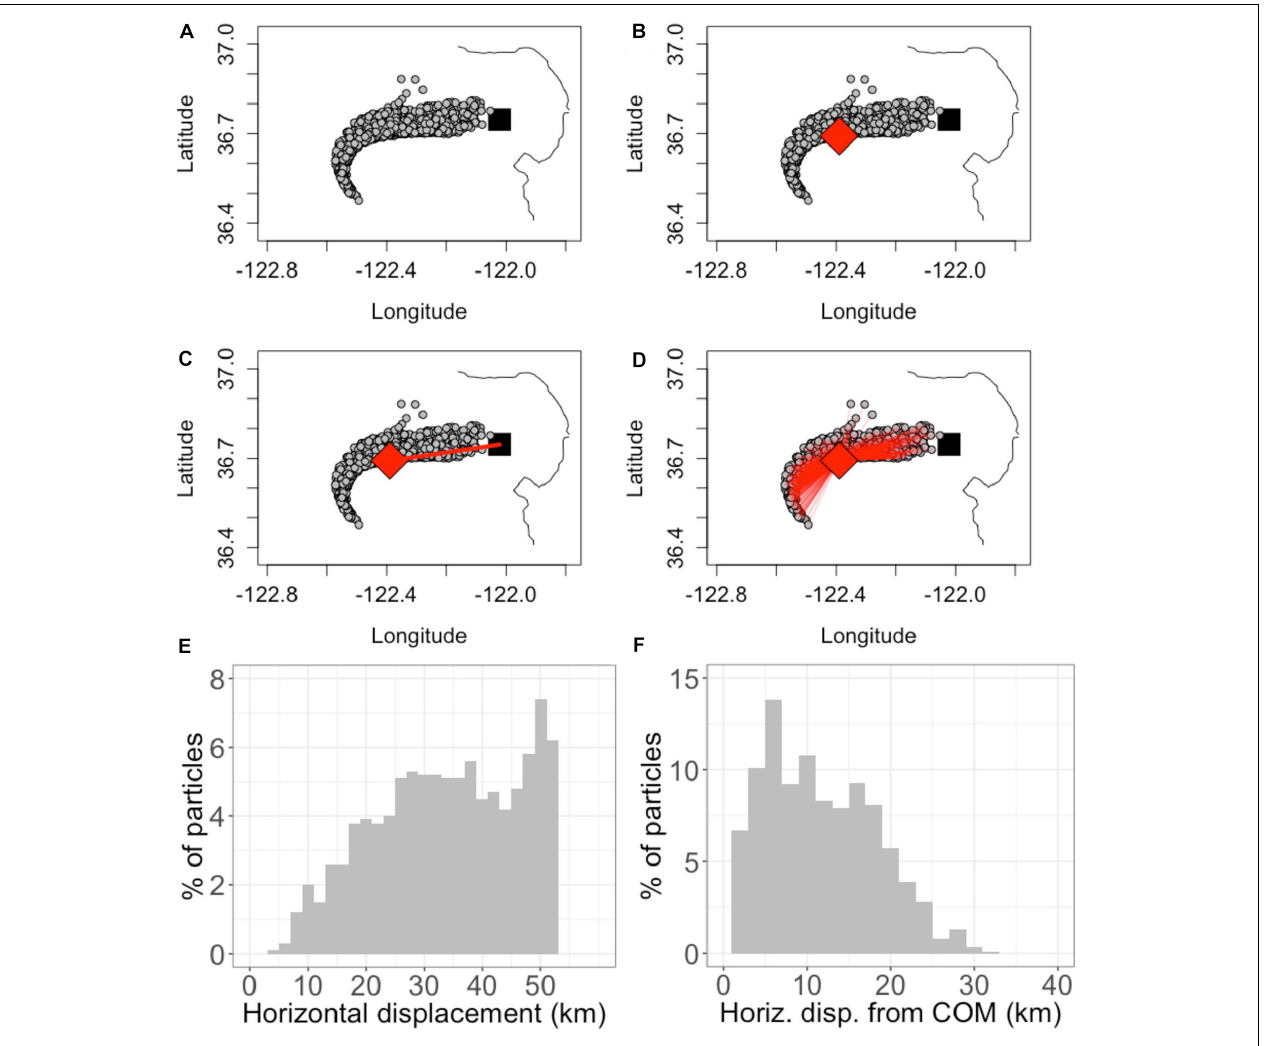
FIGURE 2 | Demonstration of horizontal displacement and spread calculations. The demonstration uses a 1000-particle subset of the 10,000 used in a sample simulation for clarity of visualization. (A) the black square is the point of release, Station M1. The gray circles show the location of particles after being subject to ocean currents for 4 days. (B) the red diamond shows the center of mass (COM) of particles after 4 days. (C) the displacement of the COM from the point of release is shown as a red line. (D) the red lines show the distance from each particle to the COM. (E) A histogram of the displacement of particles from Station M1. (F) A histogram of the displacement of particles from the COM [red lines in Panel (D) ] at this point in time (4 days since release). The horizontal displacement metric is defined as the displacement of the COM, which changes in time. The horizontal spread metric is calculated as the standard deviation of particle displacements from the COM, which also changes in time. For this demonstration, at t = 4 days, the horizontal displacement is 33 km and horizontal spread is 6.6